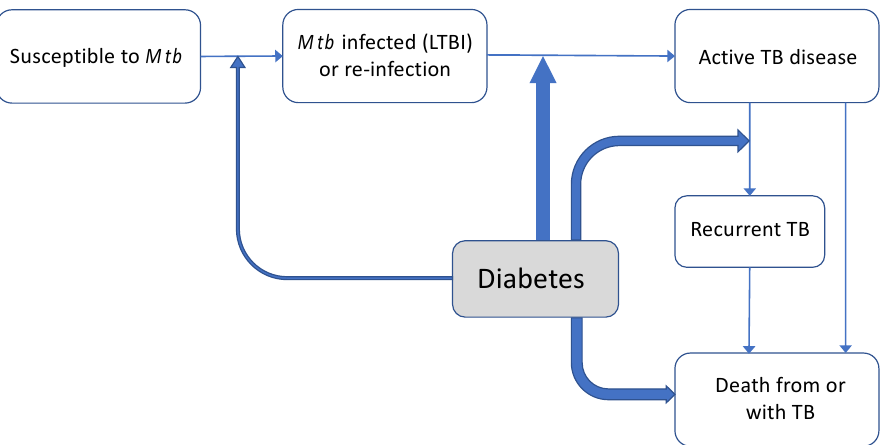
Susceptible to Mtb